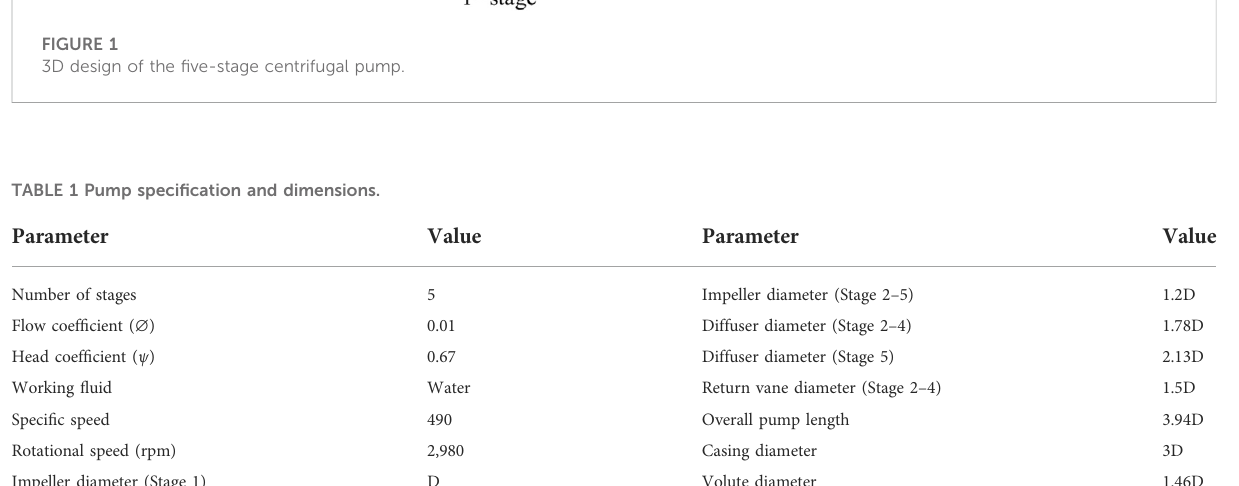
combinedhorizontalandverticaldesignatthevoluteexit.Baf fl eplates